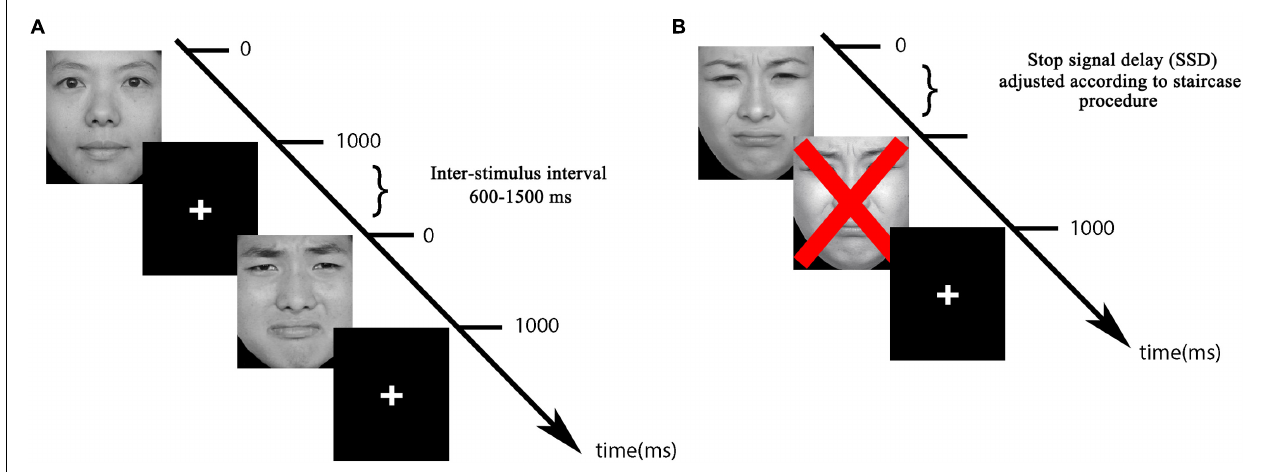
FIGURE 1 | Task trials depicting one neutral, one sad Go trial (A), and one sad Stop trial